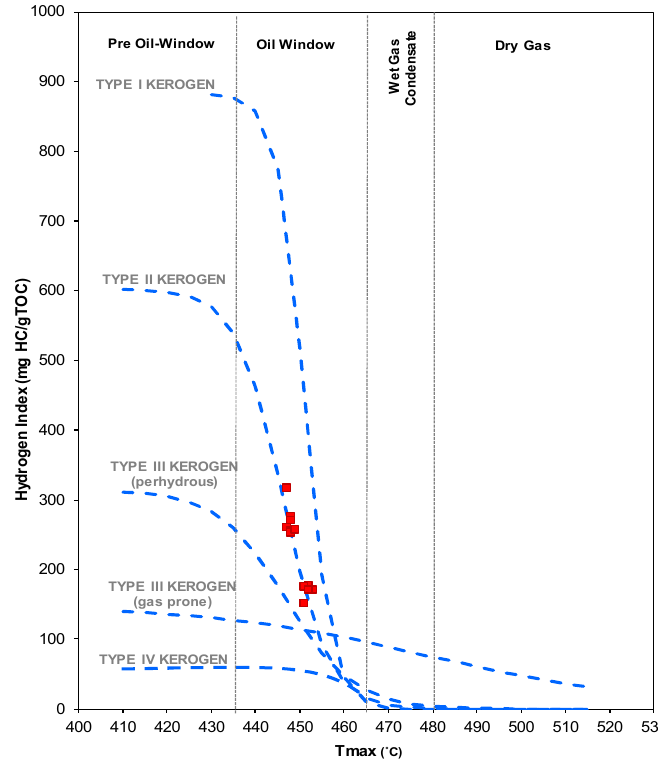
Figure 7. G vs. D5 for kerogen typing. Solid bitumen samples are also shown in this figure. As seen, solid bitumen populations can show different characters. Data points are the same as Figure 6, except for the red and black triangles that represent solid bitumen from the Eagle Ford and Bakken, respectively. Data acquired in this study with the 632 nm laser wavelength.